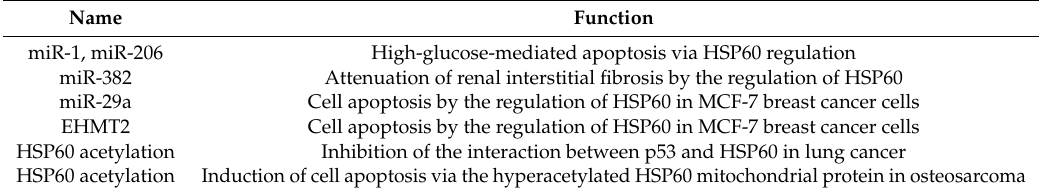
Table 1. Epigenetic regulations of heat shock protein 60 (HSP60)